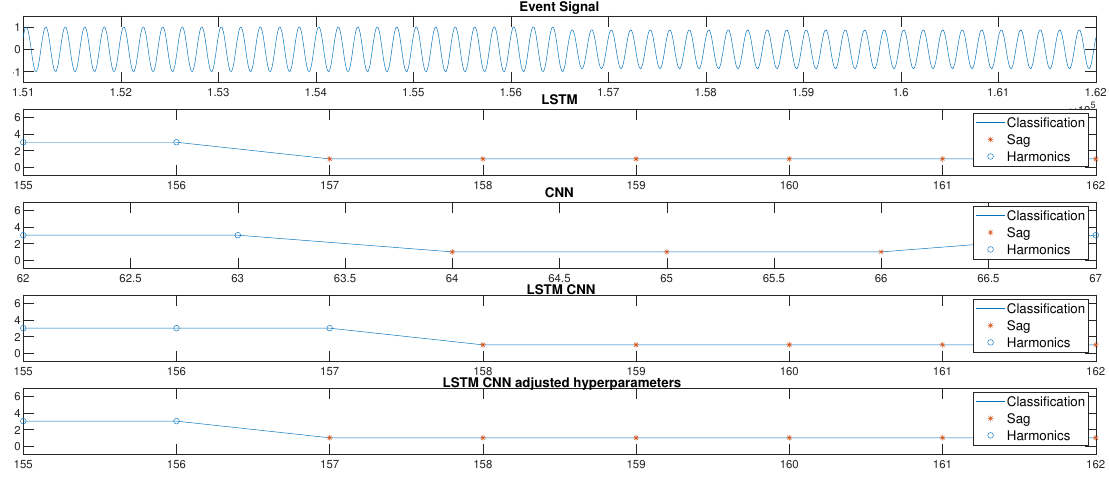
Figure 15. Voltage signal with an sag measured on the test bench (top plot). From top to bottom, the classification performances of each architecture: LSTM, CNN, LSTM-CNN and the LSTM-CNN with adjusted